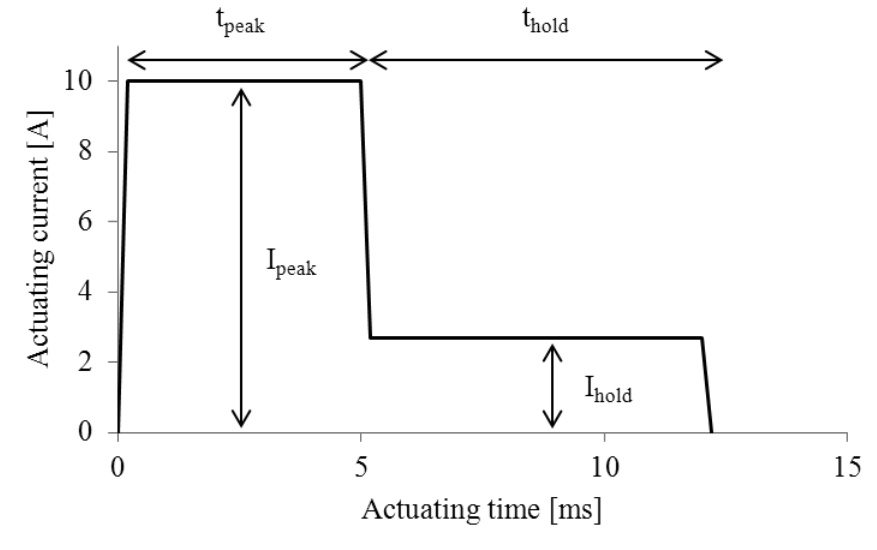
Figure 2. Scheme of the peak and hold actuation pulse, adapted from [7]. The peak current is 10 A and the hold current is 2.7 A. The duration of the peak current does not exceed 5